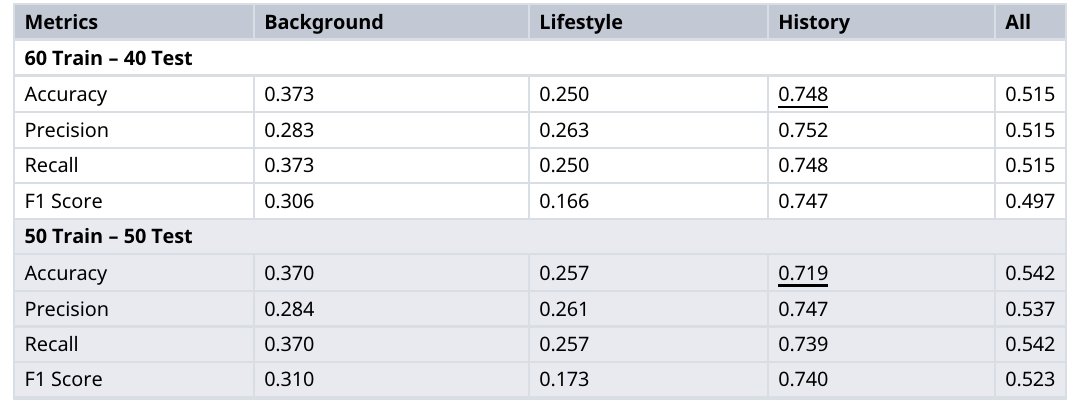
Table 9. NB (5 Levels).